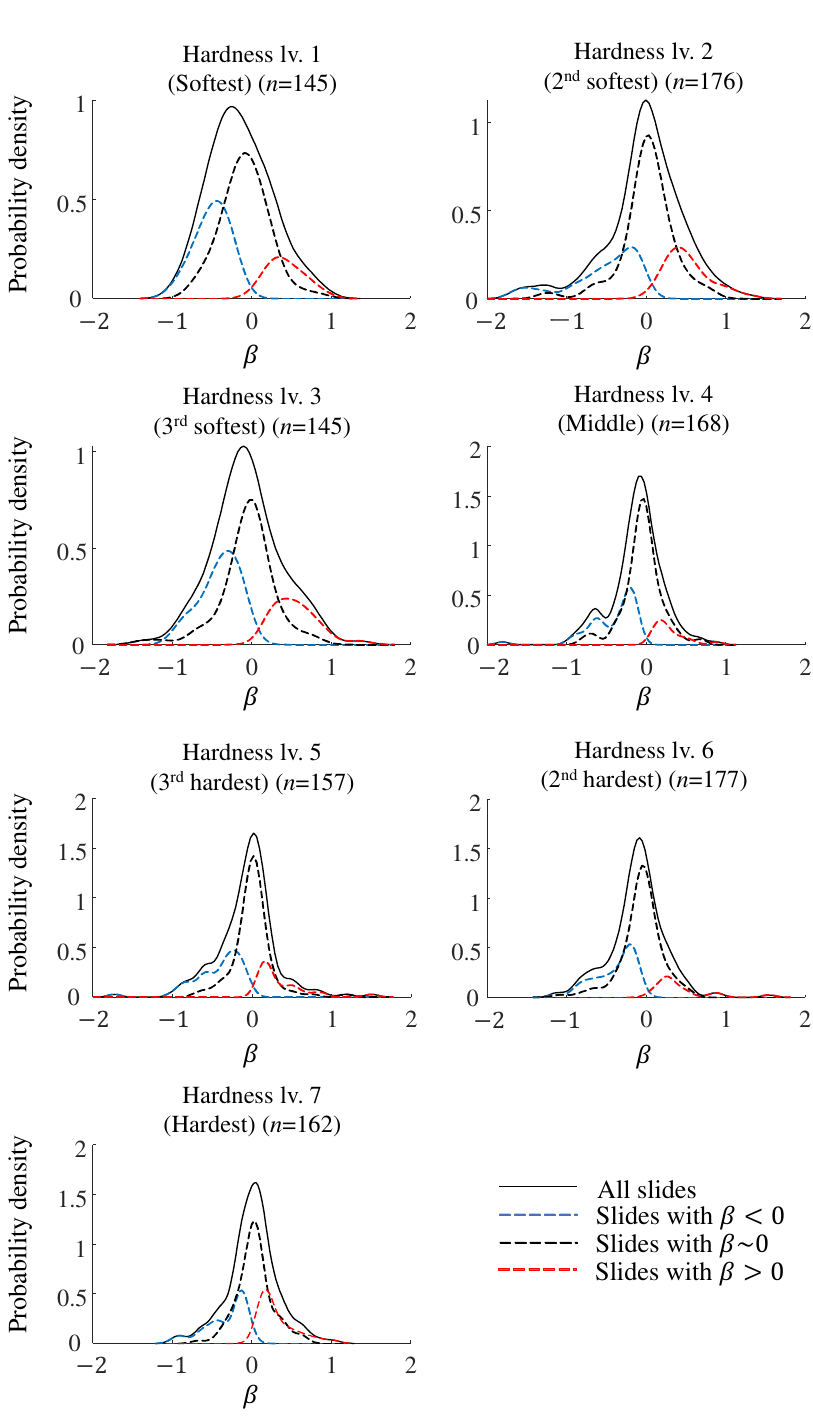
Figure 4. Probability density functions of β under case 1, in which the finger pad was wiped by a dry cloth. Solid lines include all the slides, and red, blue, and black dotted lines are the distributions of positive, negative, and insignificant β ( β ∼ 0), respectively. d = 0.8 for categorizing the sign of β